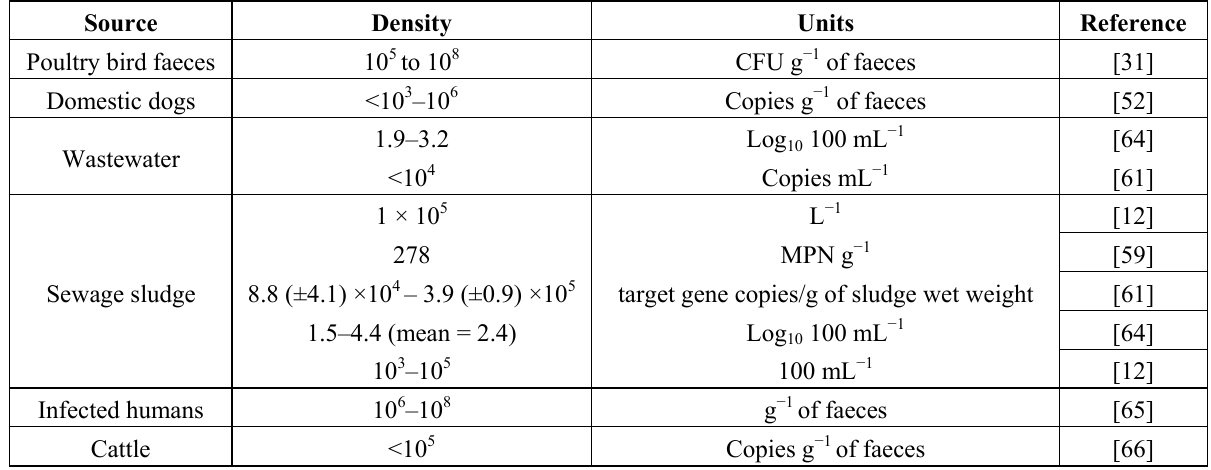
Table 1. Density of C. jejuni in various sources of